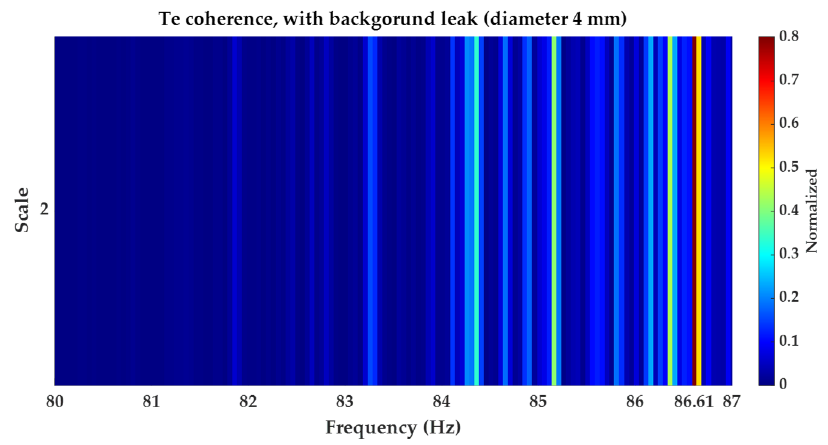
Figure 22. 𝒯 (cid:3032) coherence in Scale 2 , with background leak ( 4 mm in diameter) and flow rate